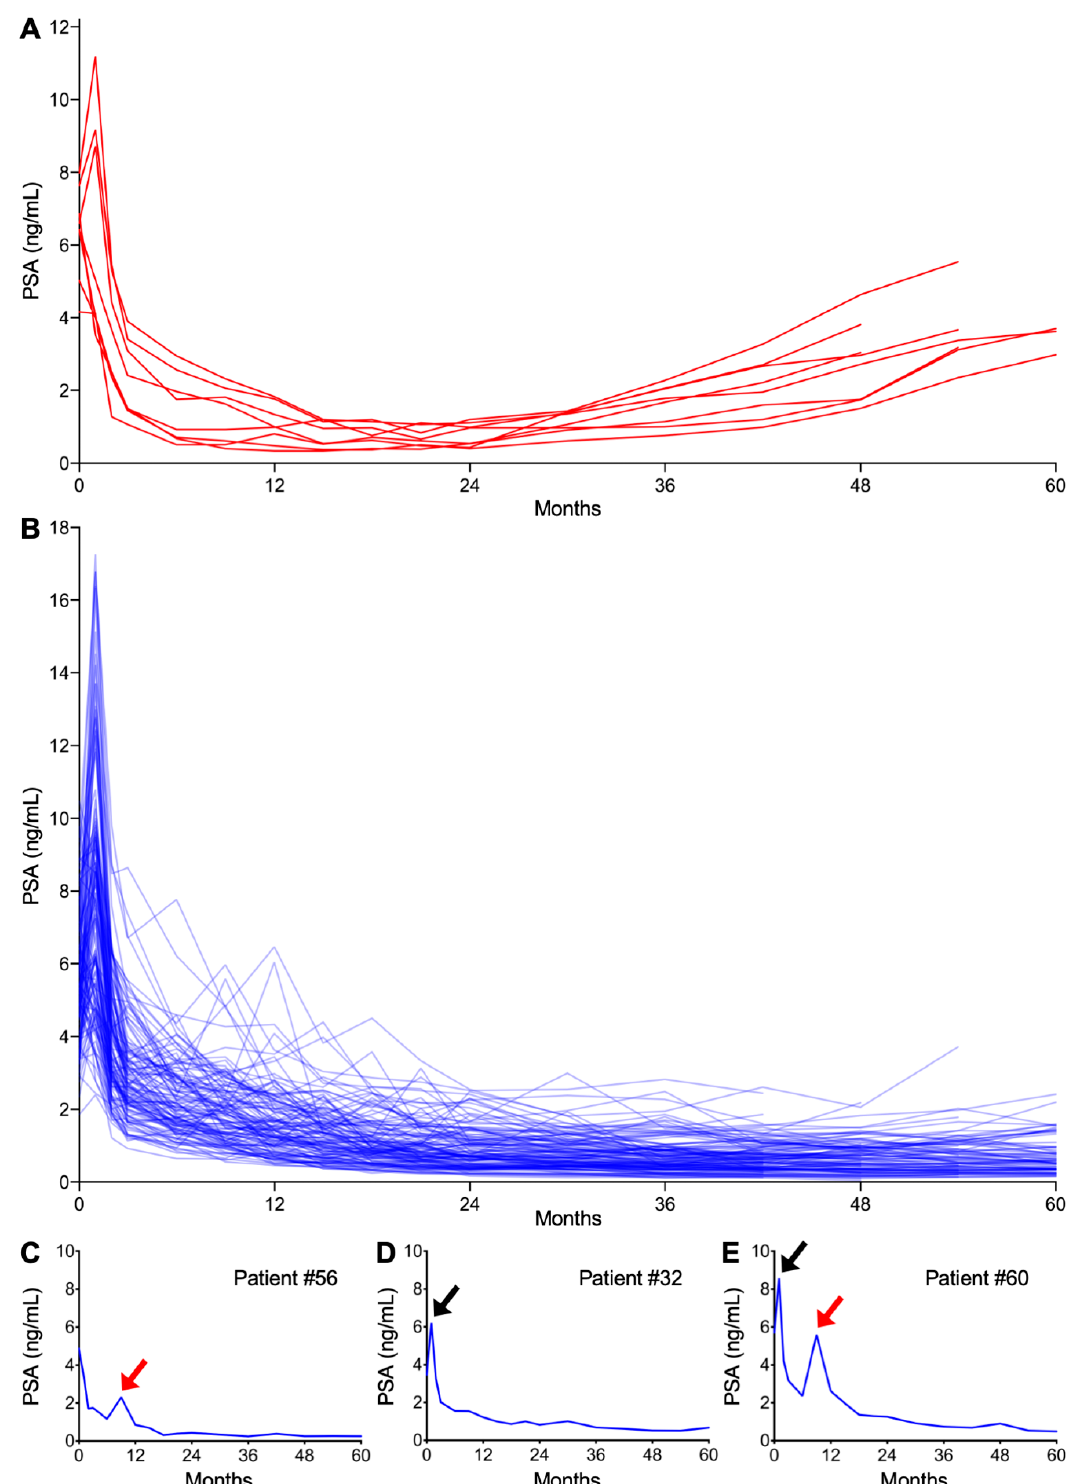
Figure 1. Post carbon ion radiotherapy (CIRT: carbon ion radiotherapy) prostate-specific antigen (PSA) kinetics. ( A ) PSA failure-positive patients ( n = 8). ( B ) PSA failure-negative patients ( n = 123). ( C – E ) Representative patients experiencing ( C ) PSA bounce, ( D ) surge, or ( E ) both. Red and black arrows indicate bounce and surge, respectively.